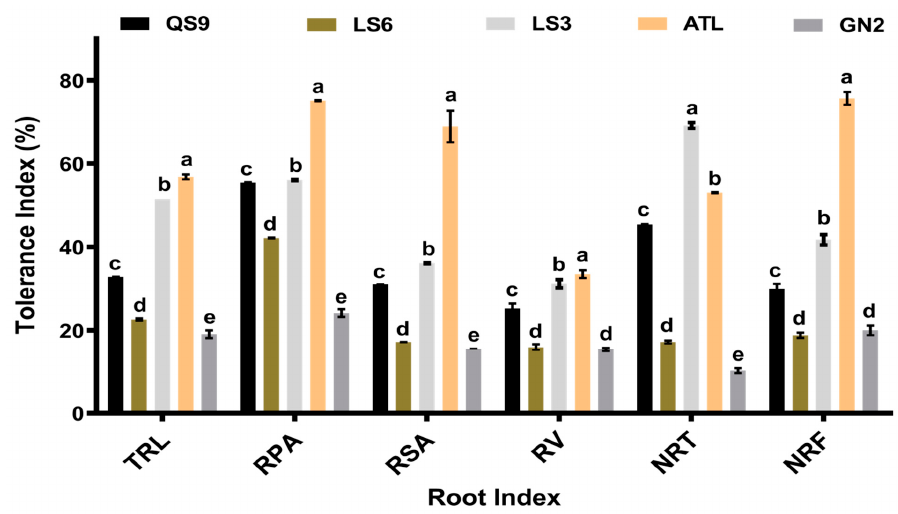
Figure 3. Root PO 3 tolerance indexes (%) of five potato genotypes under 0.5 mM Phi treatment. Qingshu9 = QS9; Longshu6 = LS6; Longshu3 = LS3; Atlantic = ATL and Gannong2 = GN2. Total root length = TRL; Root projected area = RPA; Root surface area = RSA; Root volume = RV; Number of root tips = NRT and Number of root forks = NRF. Values represent the mean of 3 replicates ± standard deviation (SD). Bars associated with different lowercase letters show significant differences by Duncan Multiple Range’s test ( p ≤ 0.05).